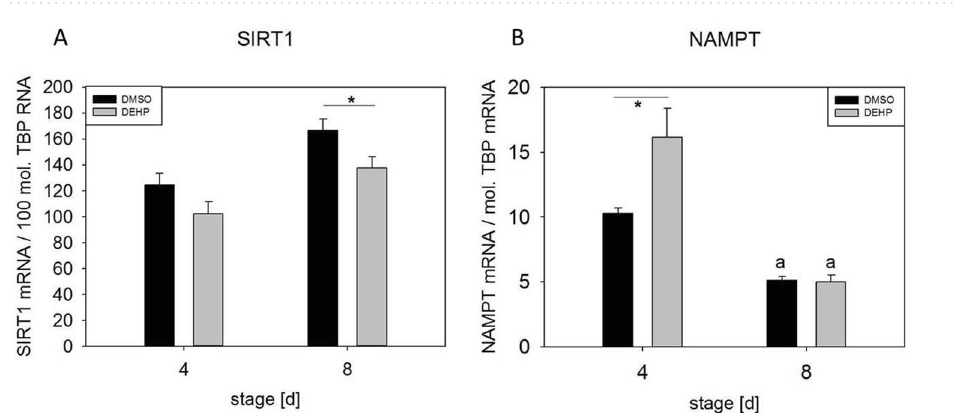
Figure 3. mRNA expression of SIRT1 ( A ) and NAMPT ( B ) in SGBS-derived cells. SGBS-derived cells were exposed to DEHP [50 µg/ml] from d0–d4 of adipogenesis. For qRT-PCR, mRNA samples of (pre)adipocytes were taken at d4 and d8 of differentiation. The TATA-Box binding protein ( TBP ) was used as a housekeeping gene. The data were statistically analyzed by one-way ANOVA on ranks with the Student–Newman–Keuls method. N = 6, n = 1 (4 pooled wells); *p ≤ 0.05 DEHP vs. DMSO at d4 or d8; a p ≤